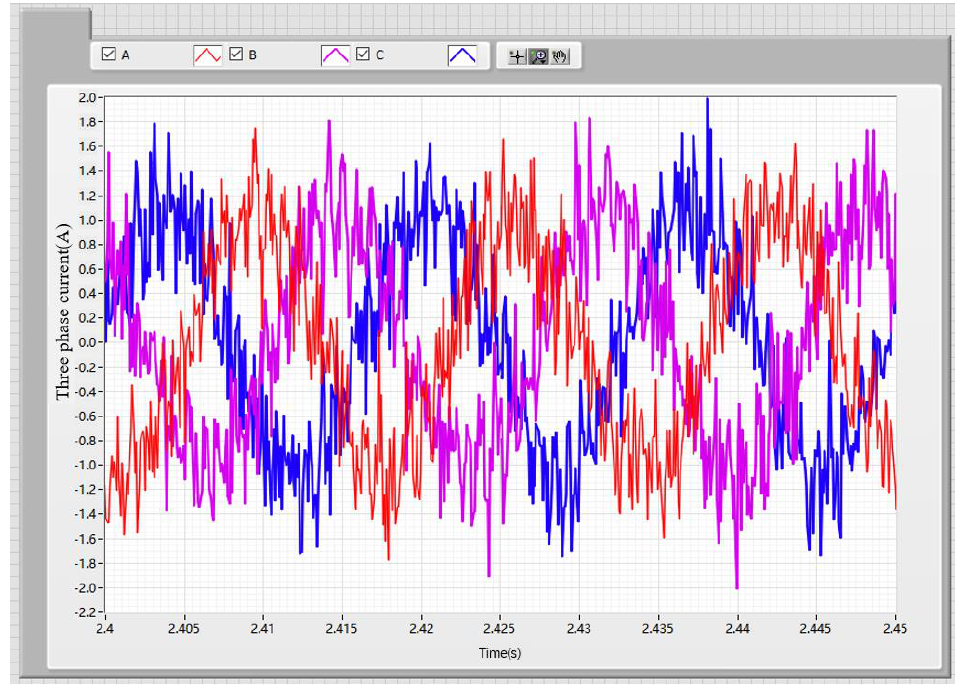
Figure 13. Sampling waveform of a three − phase current of motor in normal state.